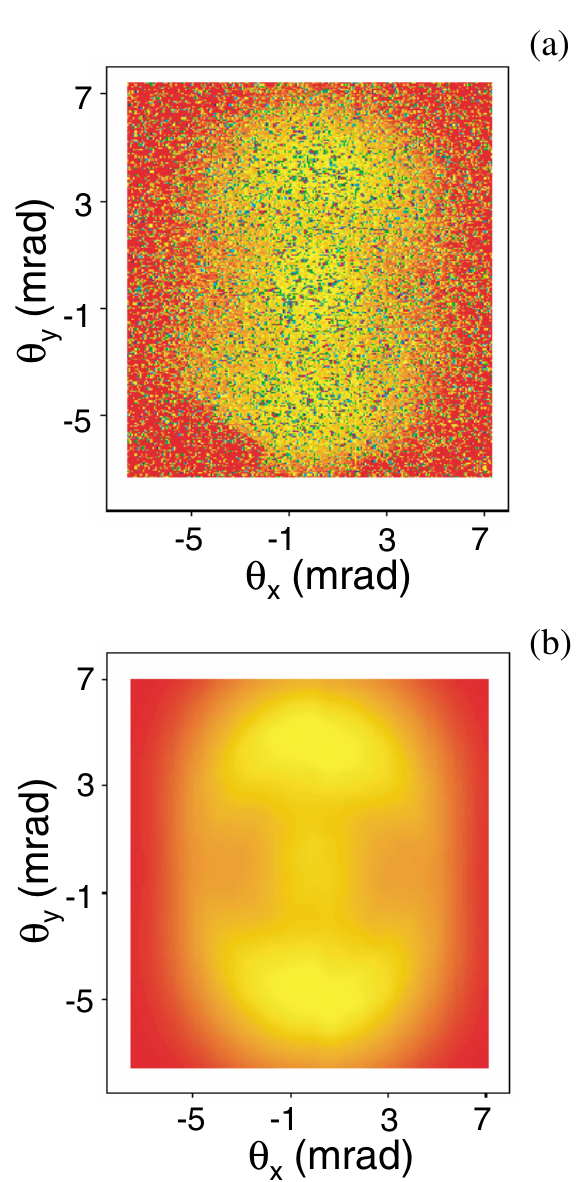
FIG. 9. (Color) Measured (a) and simulated (b) intensity pro- files for the transmission of x rays through a 0.125 mm Ta foil. The measured electron beam energy was 55 MeV, while the energy used in the simulation was 56